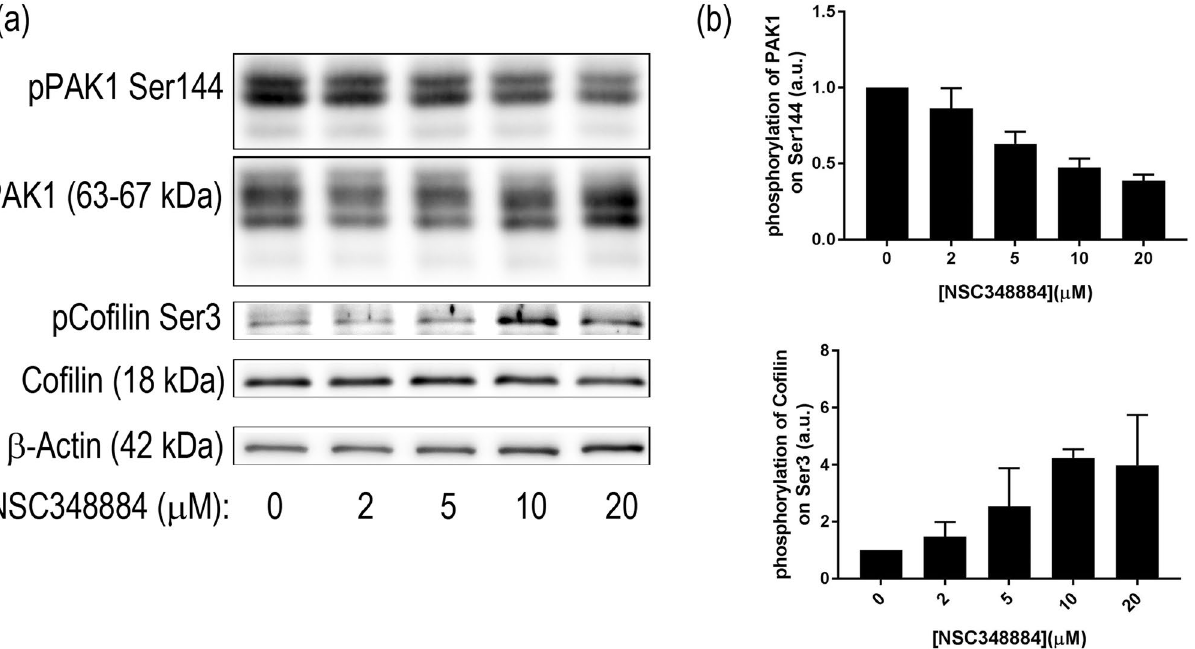
Figure 14. Expression and phosphorylation of adhesion-related protein kinase PAK1 and of the actin regulator Cofilin in 293T cells after 2 h NSC348884 treatment. ( a ) Representative blots, ( b ) summary from 2 experiments. Error bars: ±